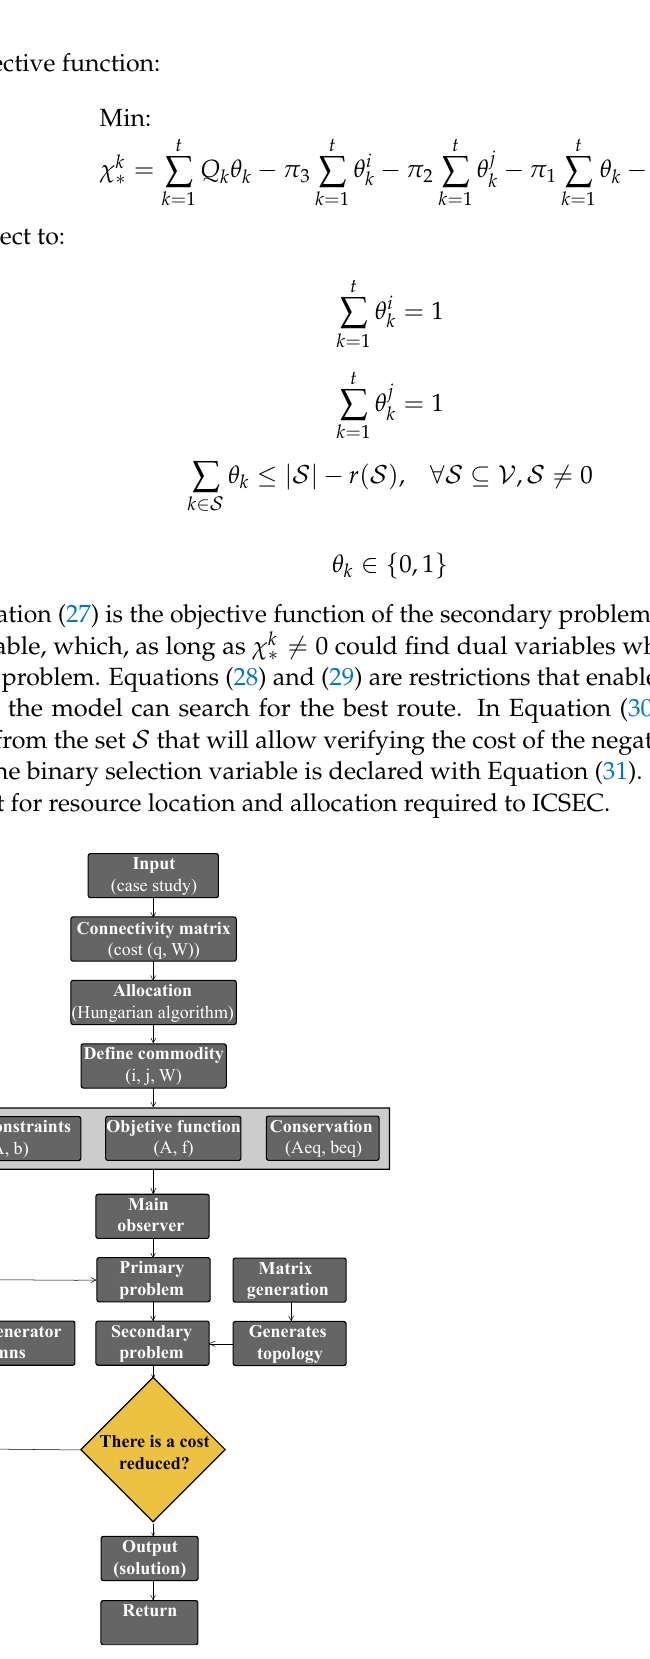
Figure 3. Flowchart for solving the Multiple-Product Problem in Location and Resource Allocation by considering Capacity